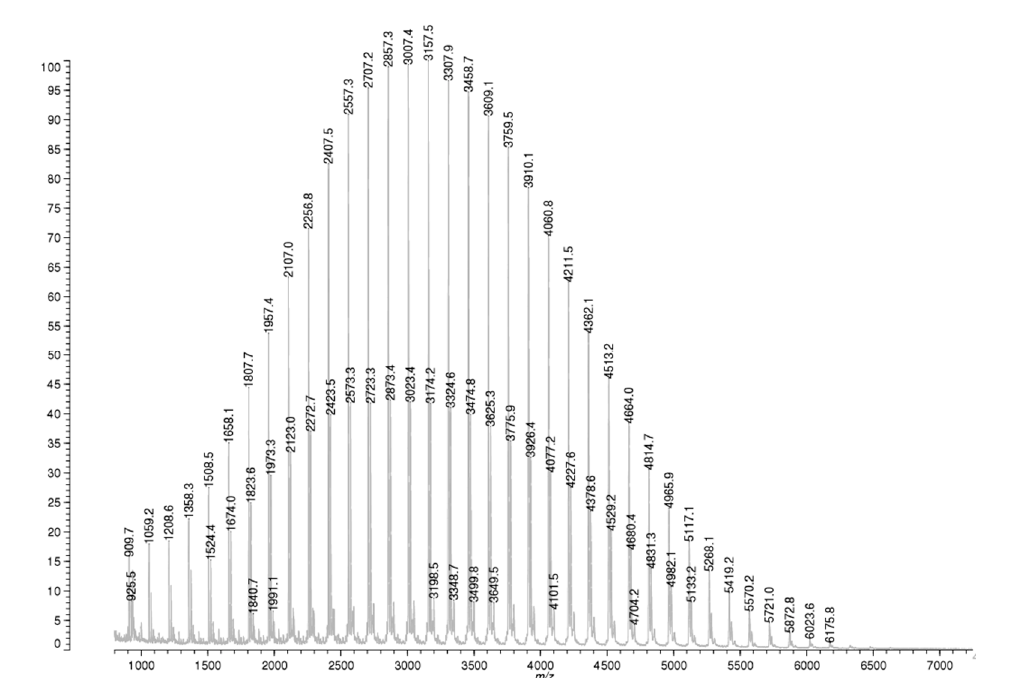
Polymers 2020 , 12 , x FOR PEER REVIEW 12 of 25 Figure 8. 13 C NMR spectrum of PAGE-diol (7) obtained with K-DPG. Figure 8. 13 C NMR spectrum of PAGE-diol (7) obtained with K-DPG.